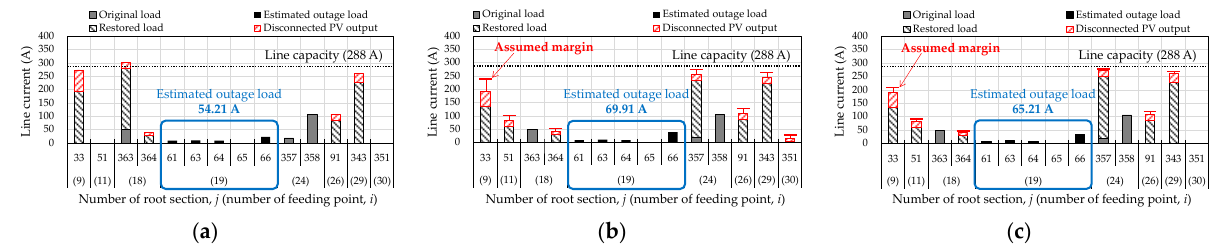
Figure 8. Line currents in each restoration configuration: ( a ) traditional framework; ( b ) proposed framework ( ξ = 0.7); ( c ) robust optimization framework ( ξ =